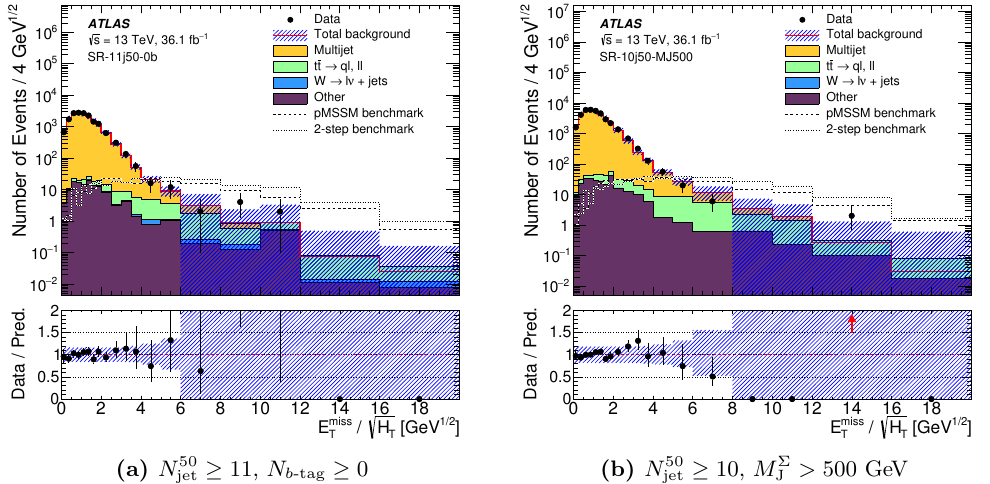
p Figure 5. Distributions of the E miss = H T for events in the 11-jet SR for the 50 GeV (cid:13)avour T channel, inclusive in N b -tag (a) and the 10-jet SR for the jet mass channel (b), with M (cid:6) > 500 GeV. J The backgrounds are scaled by the normalisation factors extracted from the (cid:12)t, described in section 6.3. The blue hatched band indicates the quadrature sum of the statistical uncertainty from MC simulated samples and the various systematic uncertainties in the background pre- diction. The dashed lines labelled ‘pMSSM’ and ‘2-step’ refer to benchmark signal points | a pMSSM slice model with ( m ~ g ; m ) = (1400 ; 200) GeV and a cascade decay model with ~ (cid:31) (cid:6) 1 ( m ~ g ; m ) = (1400 ; 200) GeV. The lower panels show the ratio of the observed data to the to- ~ (cid:31) 0 1 tal SM background. Red arrows indicate data points for which the error bar does not intersect the ratio